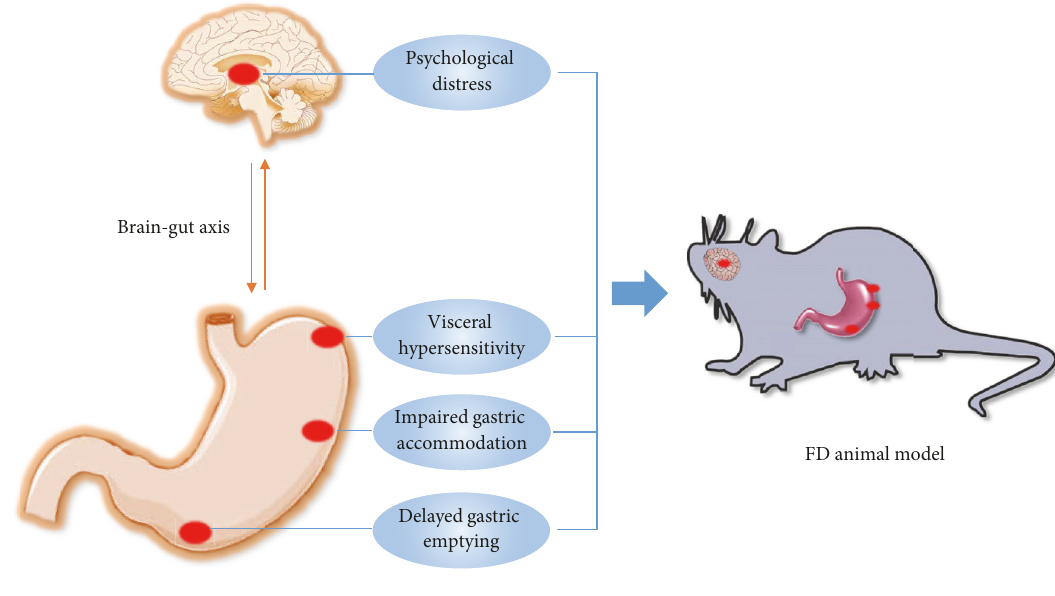
Figure 1: Delayed gastric emptying, impaired gastric accommodation, visceral hypersensitivity, and psychological distress are the major pathophysiologic disturbances of FD. These points are also targets of FD animal model.